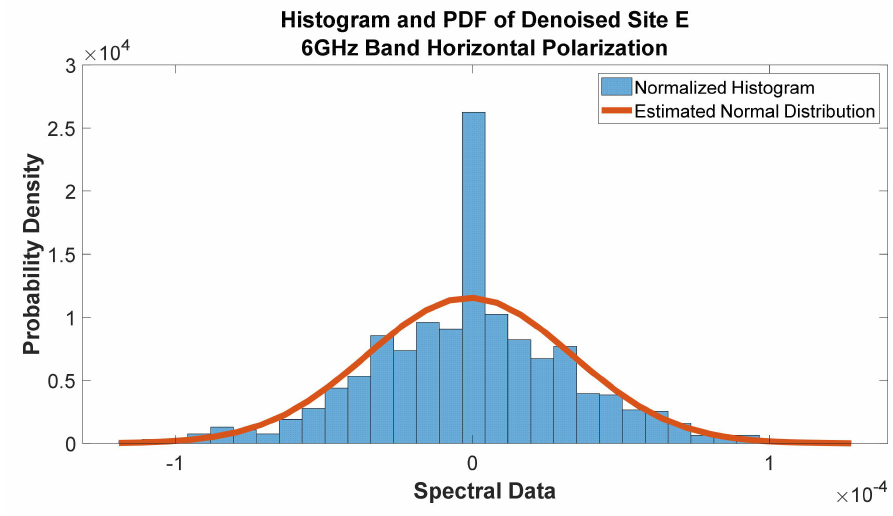
Figure 48. Histogram and PDF of Denoised Site E at 6 GHz band horizontal polarization.